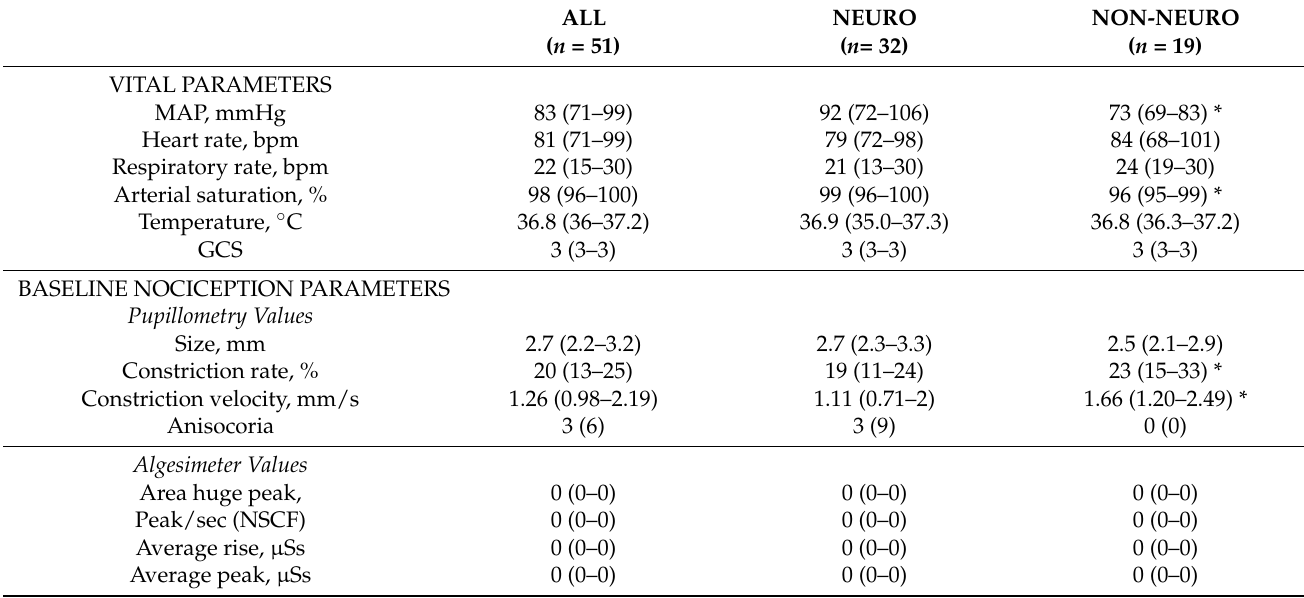
Table 2. Characteristics of patients on the day of nociceptive stimulation assessment. Subgroup analysis comparing patients with primary brain injury (“NEURO”) and others is also reported. Data are presented as count (%) or median (IQRs).